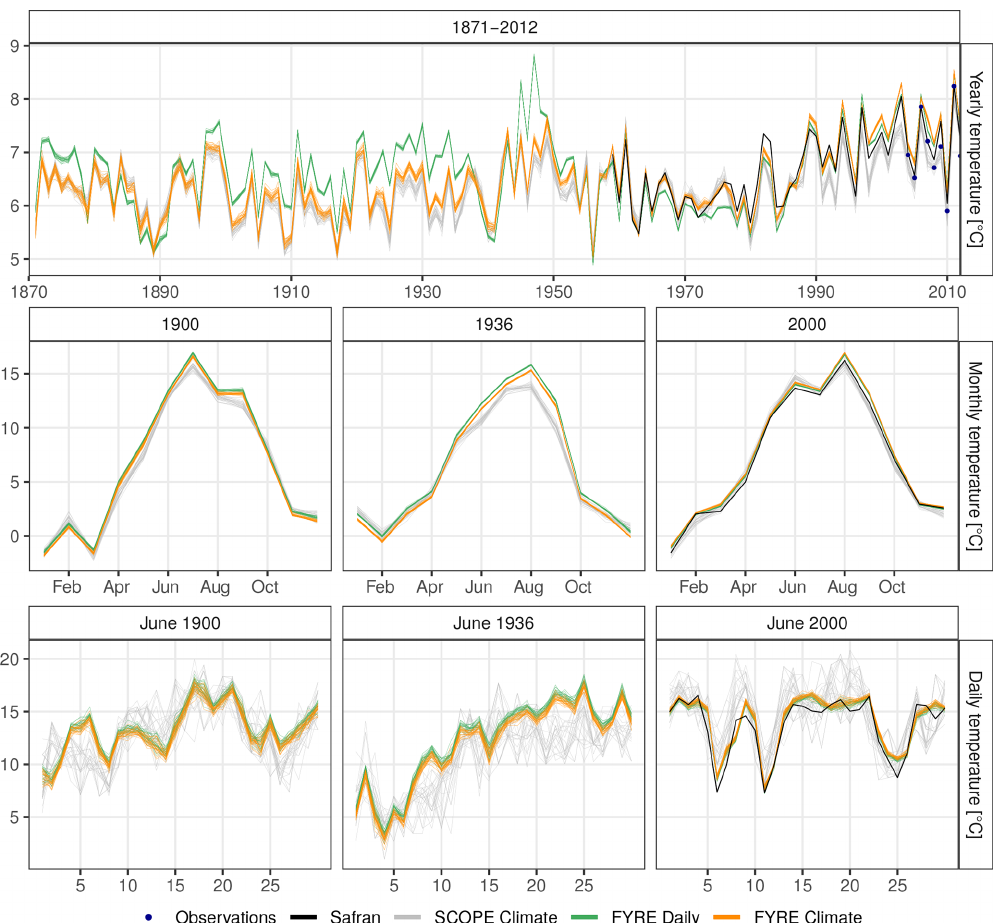
Figure 9. Temperature time series of SCOPE Climate, FYRE Climate, FYRE Daily, and Safran over the case study cell for different periods and different time